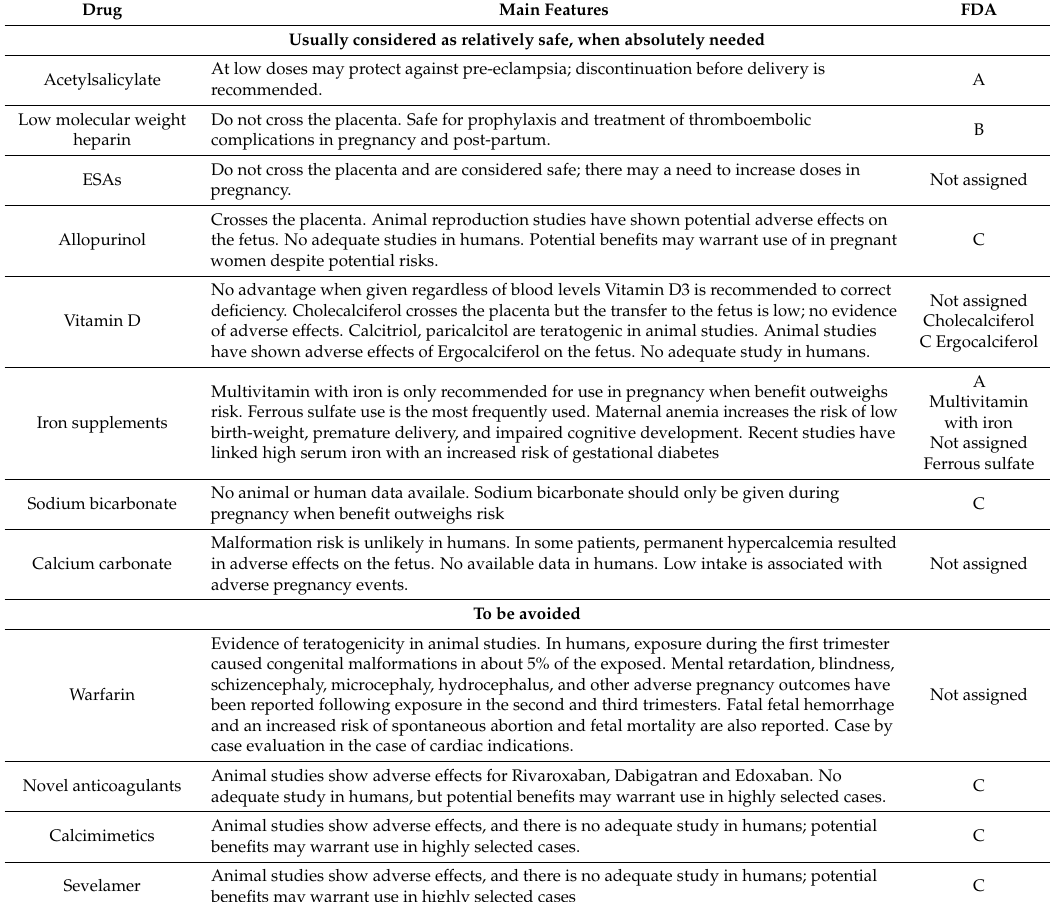
Table A4. Other commonly prescribed drugs for CKD patients in